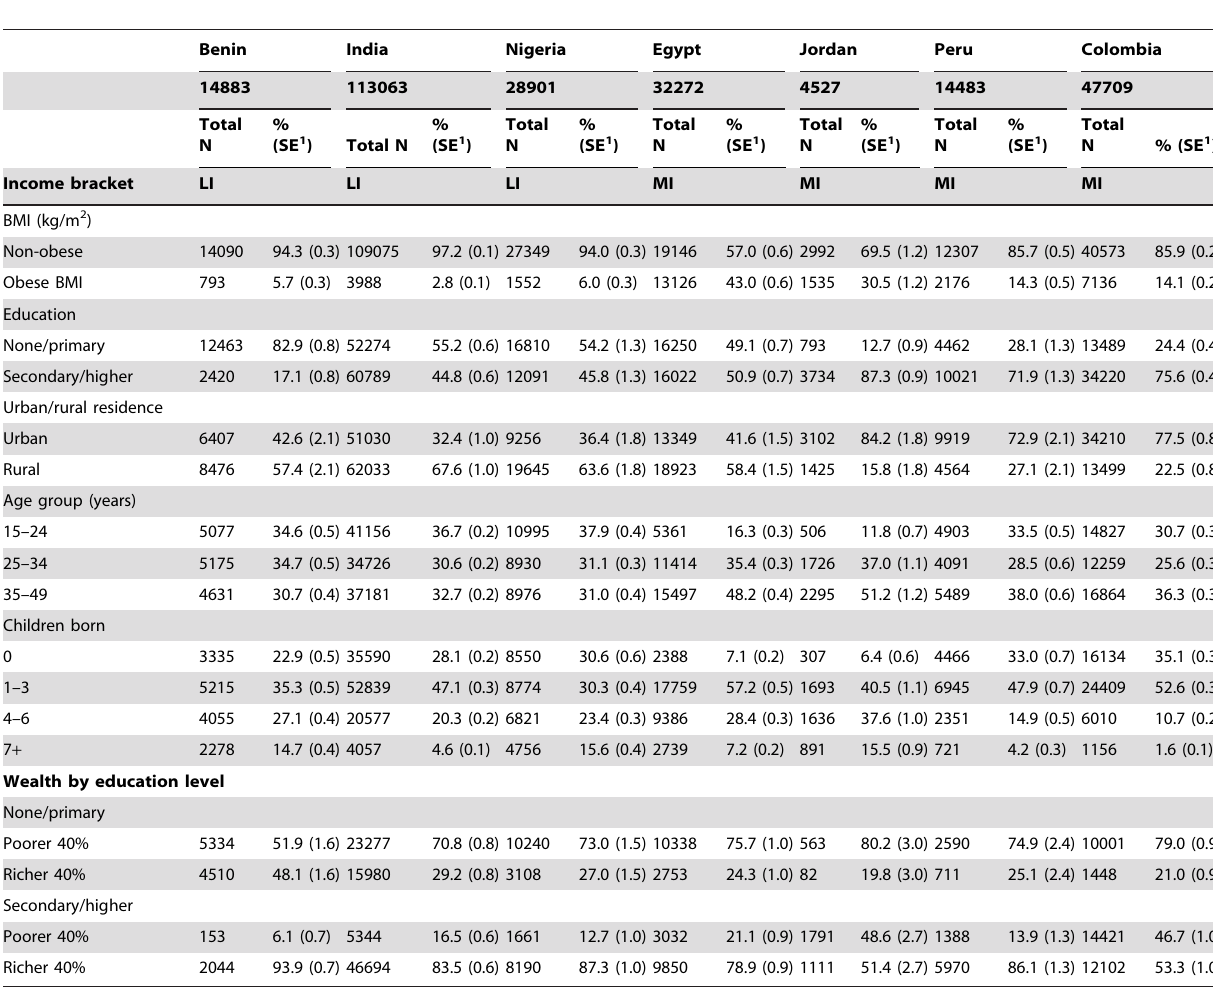
Table 2. Participant sociodemographic characteristic in each country, DHS